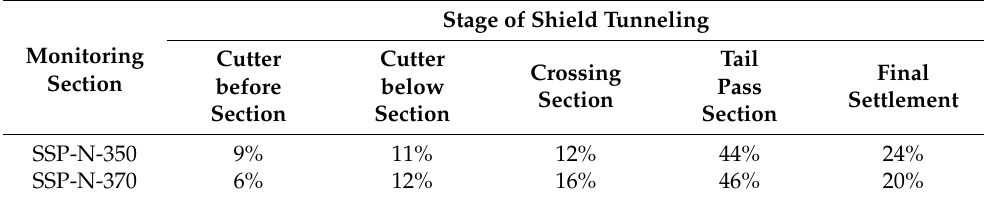
Stage of Shield